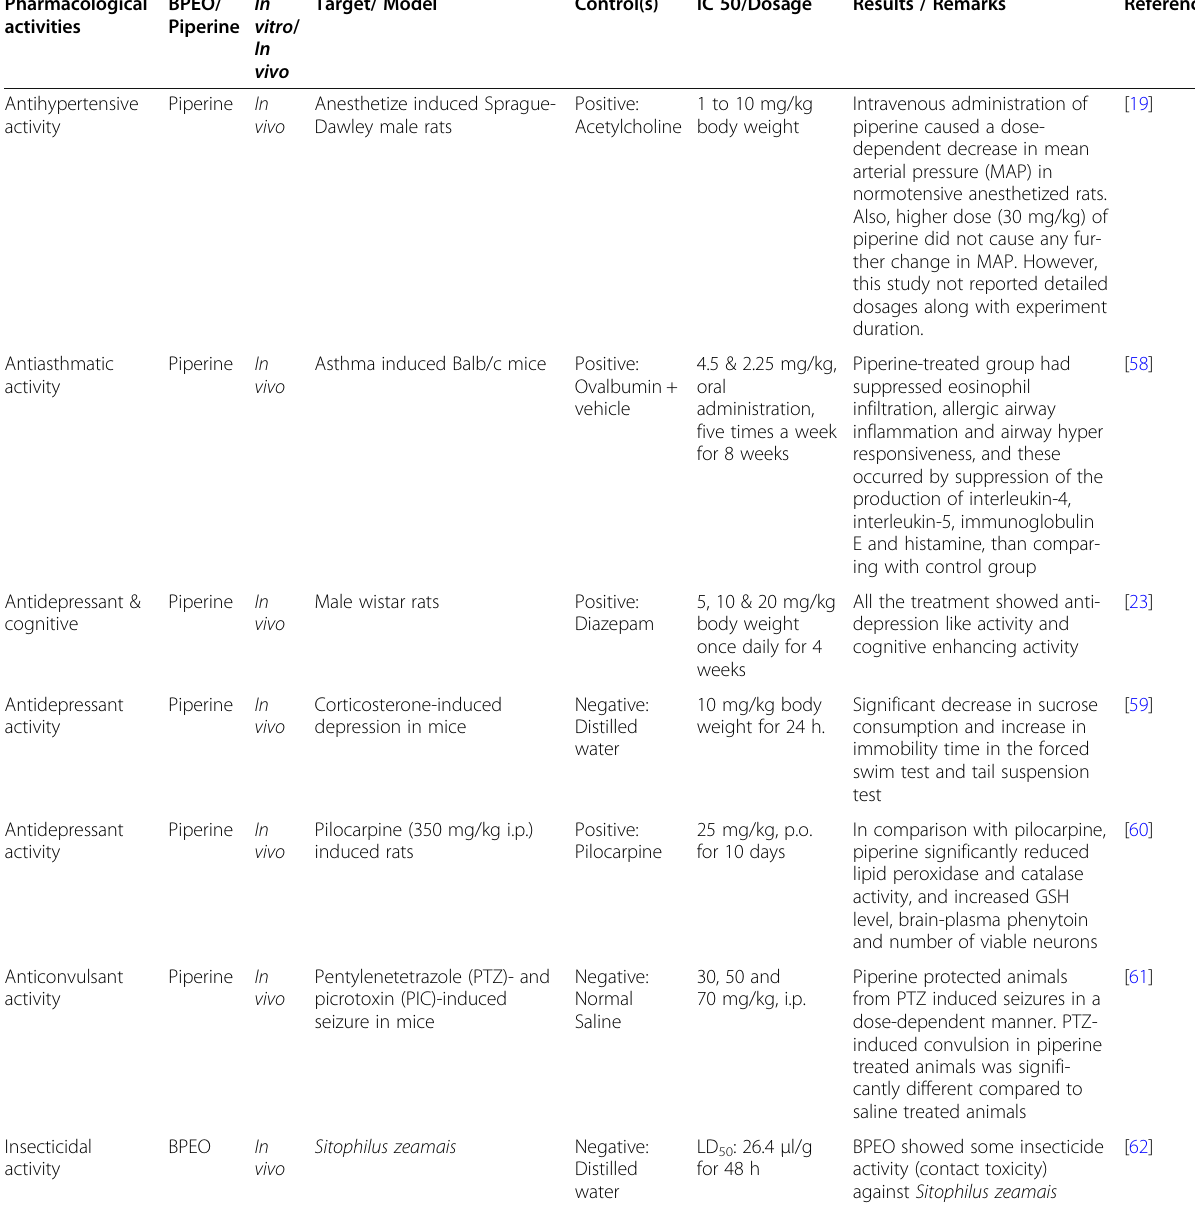
Table 4 Pharmacological activities of Piper nigrum extracts, piperine and BPEO (Continued) Pharmacological